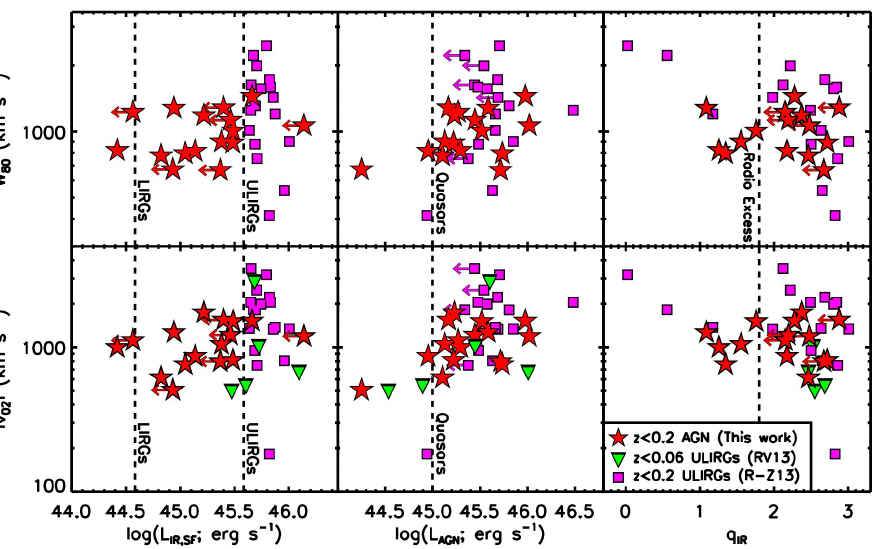
Figure 13. Outflow velocity vs. infrared luminosity from star formation ( left ), AGN luminosity ( middle ), and q IR ( right ) for nearby AGN (red stars; [221]), ULIRGs (green triangles; [196]), and ULIRG-AGN composites (magenta squares; [223]). The most extreme velocities appear to be preferen- tially found in ULIRGs that host quasars. Figure adapted from Harrison et al. [221] with